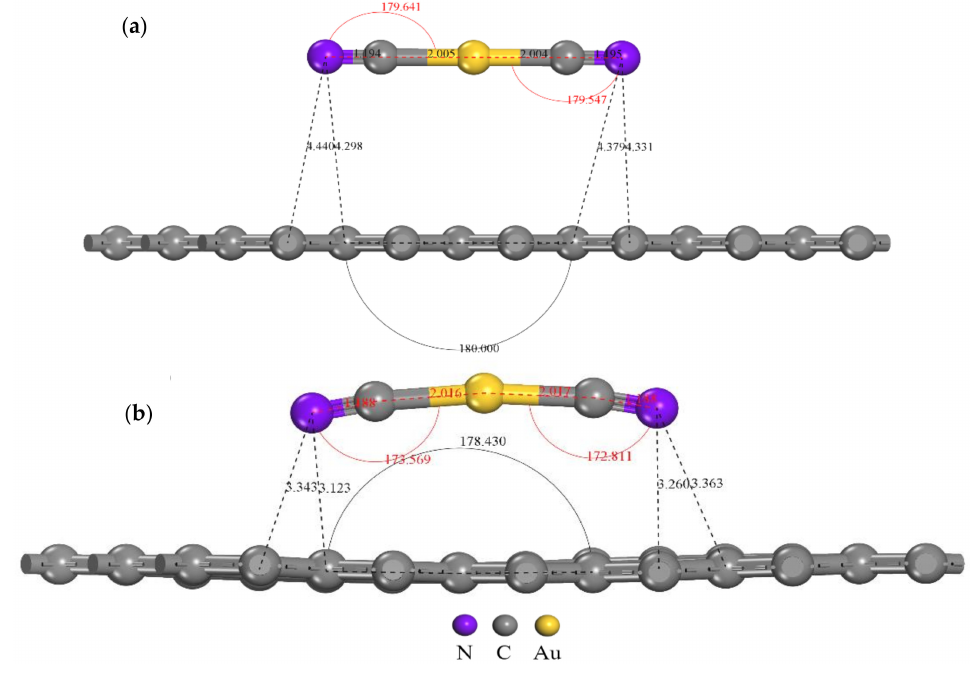
Figure 4. Adsorption configuration: ( a ) initial adsorption configuration, ( b ) optimized adsorption